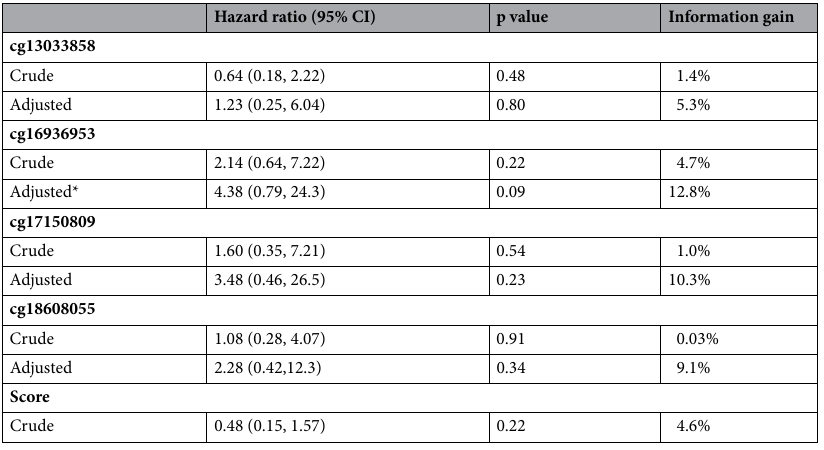
Table 2. Hazard ratio per 10% unit increase in methylation beta value derived from the regression coefficient from a conditional logistic model among monozygotic twins discordant for total cardiovascular death. CI confidence interval. Adjusted hazard ratios were obtained after control for a principal component score representing age, years of education, smoking status, body mass index, systolic blood pressure, low-density lipoprotein cholesterol, high-density lipoprotein cholesterol, use of antihypertensives, presence of diabetes, and leukocyte subtypes. *p < 0.05 likelihood ratio test for the adjusted model in which the score had an adjusted p-value of